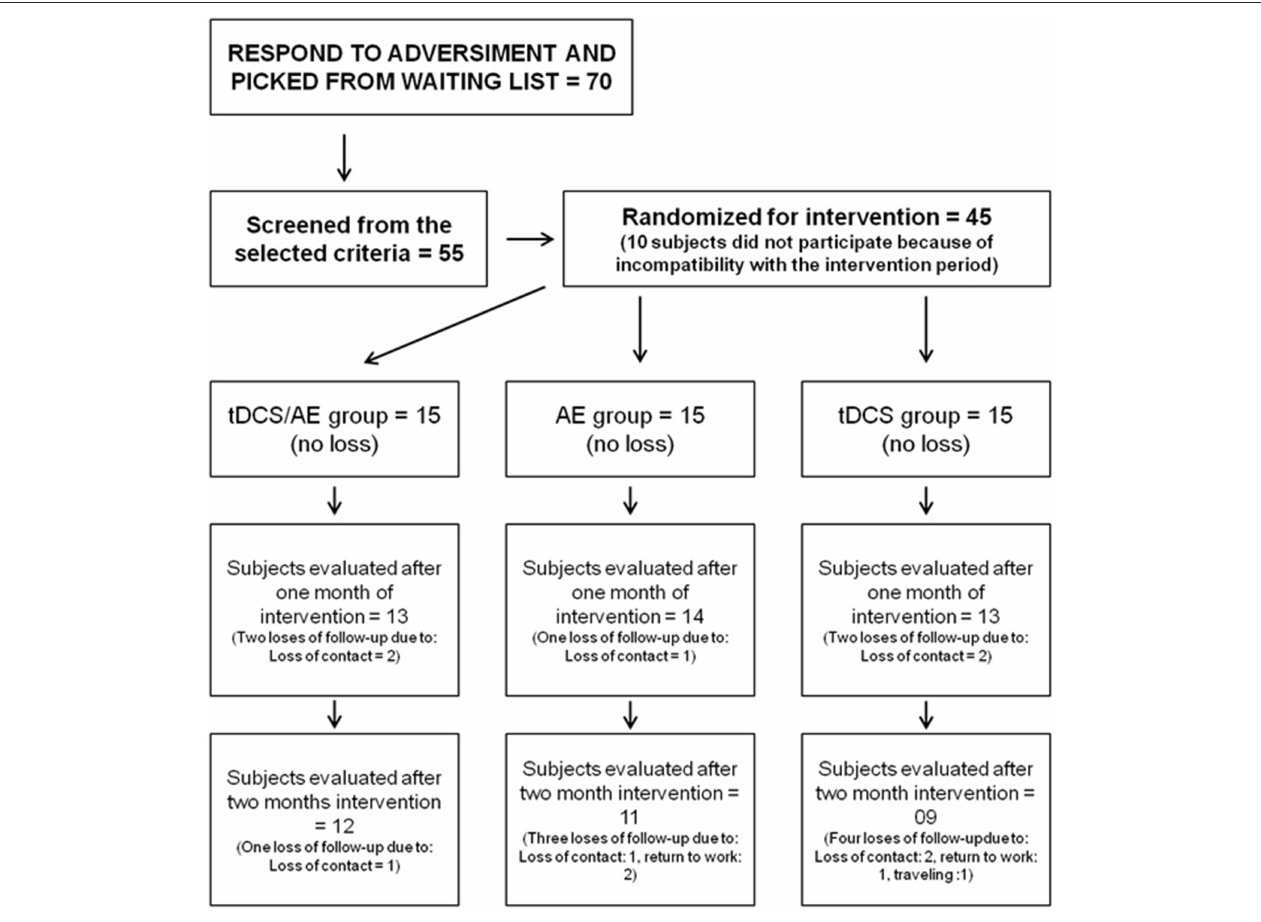
FIGURE 1 | Research